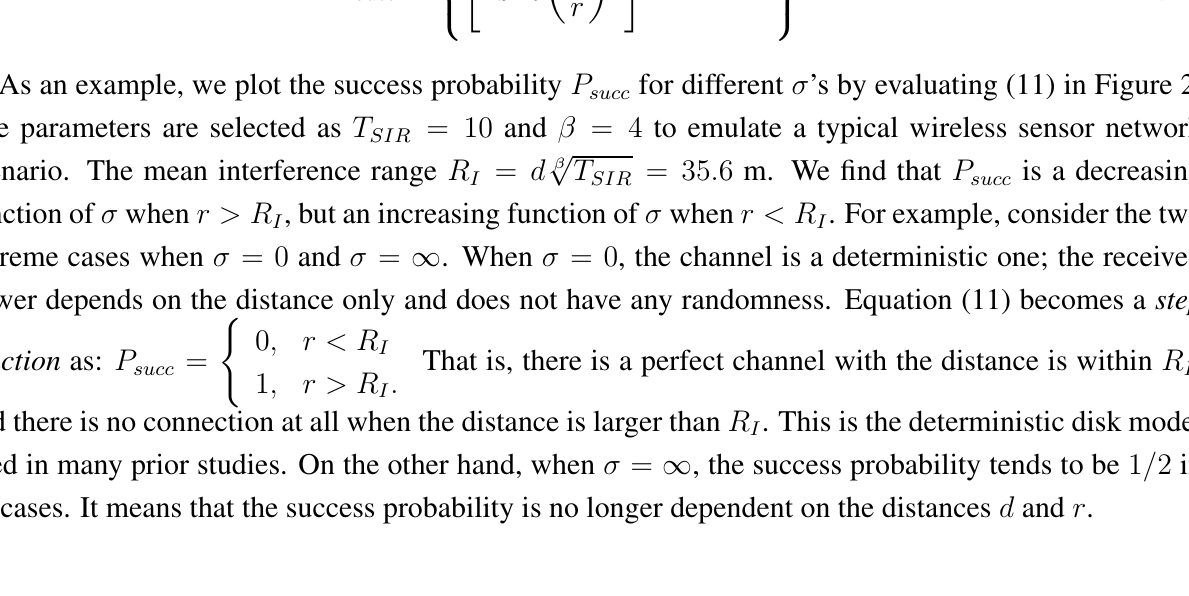
with T = 10 succ SIR